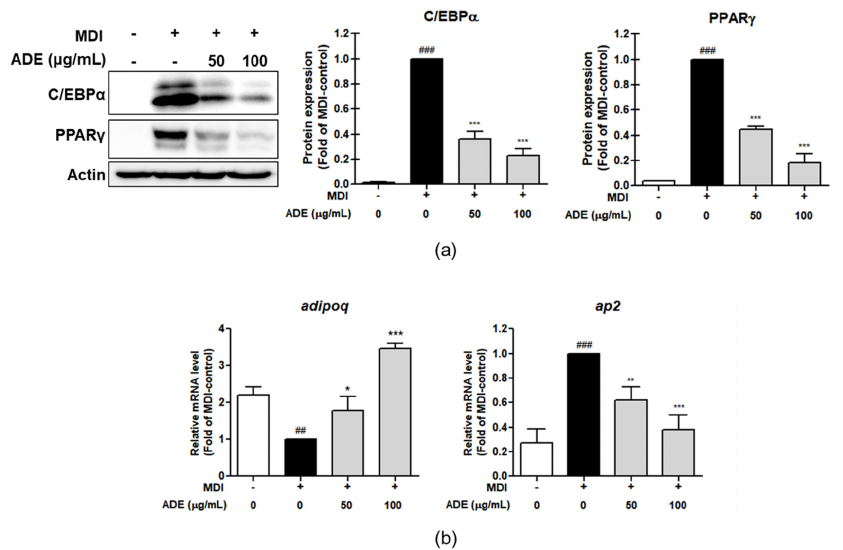
Figure 3. E ff ect of ADE on levels of adipogenic-related proteins and mRNA in 3T3-L1 adipocytes. Differentiating 3T3-L1 cells were treated every 2 days with extracts (50 and 100 μ g/mL) for 8 days in adipocyte-induction media. Protein expressions C/EBP α and PPAR γ were performed by Western blotting ( a ). The mRNA expressions of adipoq and ap2 were evaluated by the quantitative real-time PCR ( b ). Relative levels were normalized to their β -actin ( n = 3). ## p < 0.01 and ### p < 0.001 vs. non-MDI treated control; * p < 0.05, ** p < 0.01 and *** p < 0.001 vs. MDI treated control. MDI, media of di ff erentiation; ADE, A. dioicus extract. Processes 2020 , 8 , 1576